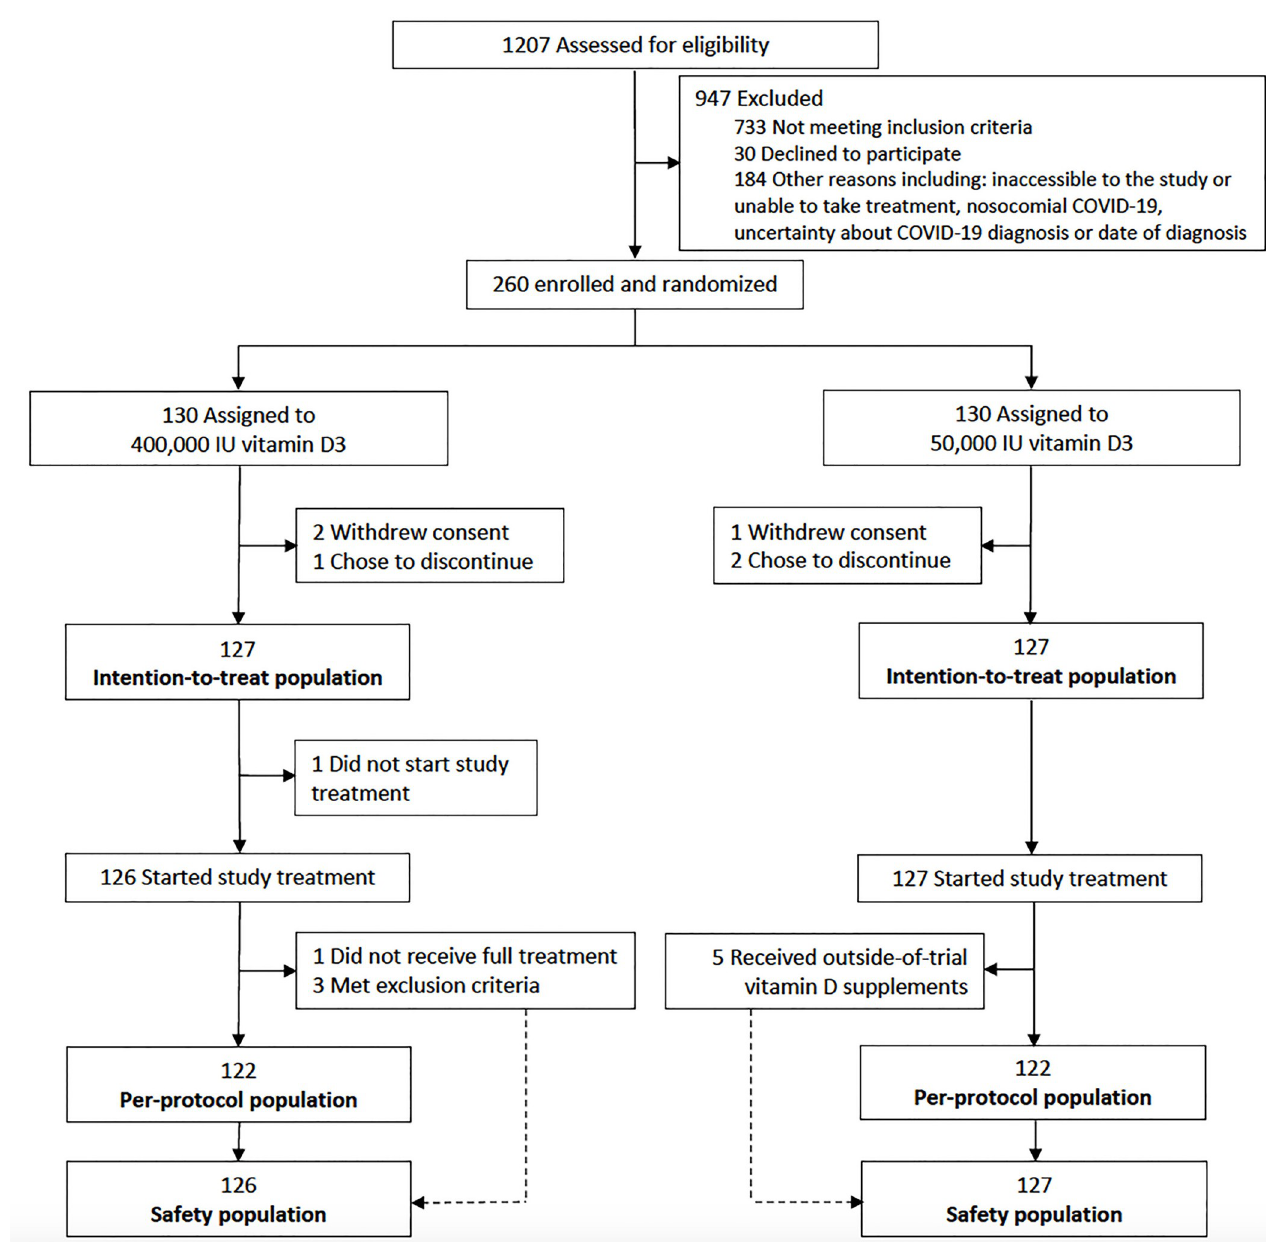
Fig 1. Screening, randomization, and follow-up of the participants in the COVIT-TRIAL study. COVID-19, Coronavirus Disease 2019; COVIT-TRIAL, COvid19 and VITamin d TRIAL.